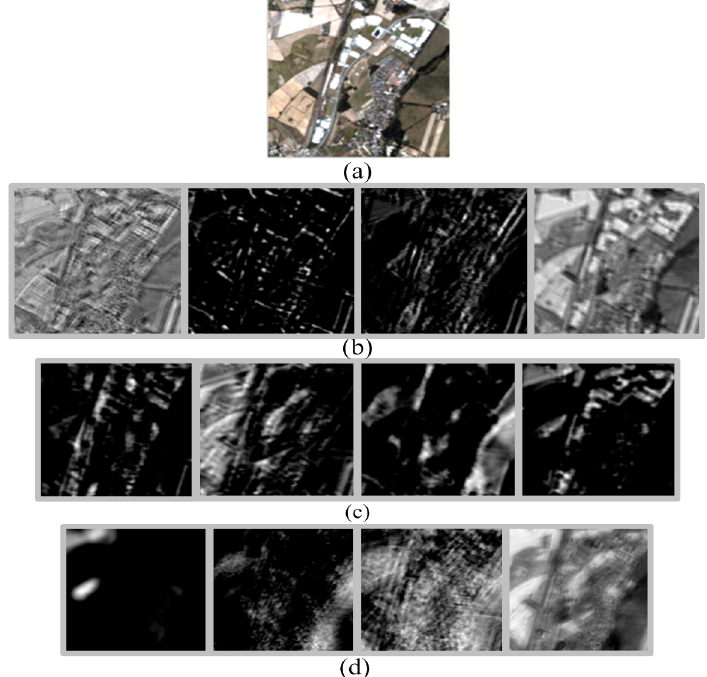
Figure 18. The extracted feature maps of different convolutional layers in MSI branch, the features are extracted from simulated MSI with size 128 × 128, the data is simulated from EnMAP Berlin data, ( a ) input MSI data; ( b ) feature maps of the first layer; ( c ) feature maps of the second layer; ( d ) feature maps of the third layer.